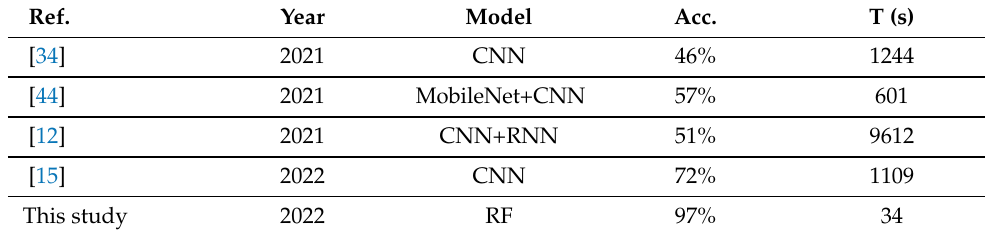
Table 15. Comparison with existing state-of-the-art approaches. Ref.